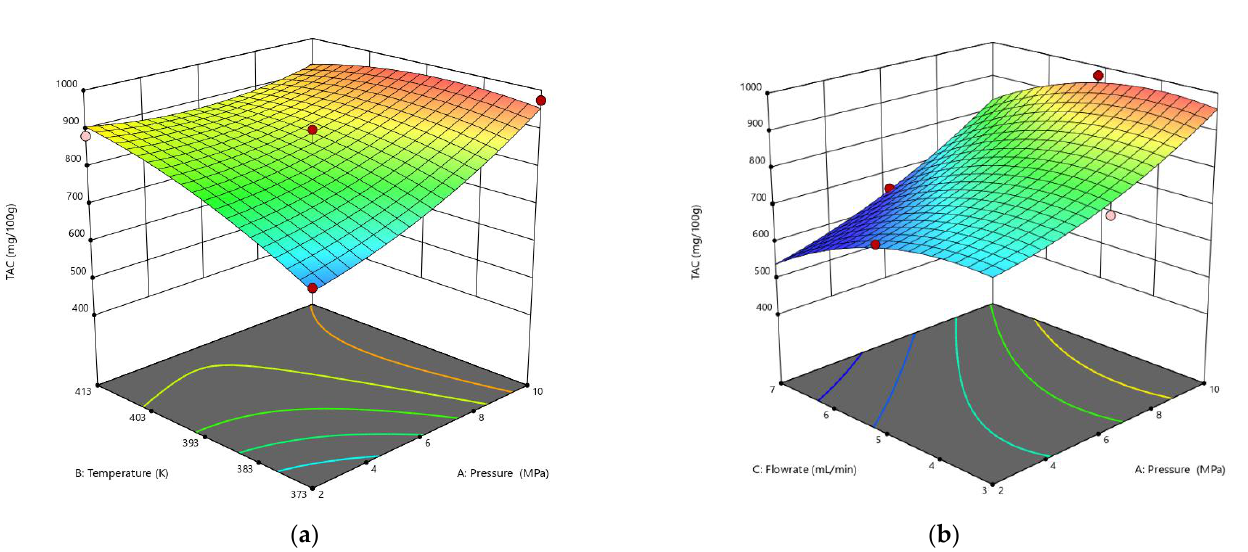
Figure 4. The 3D response of the effects of variables on the total anthocyanin content (TAC) (mg/100 g) at ( a ) a constant flow rate of 5 mL/min and ( b ) a temperature of 393 K.